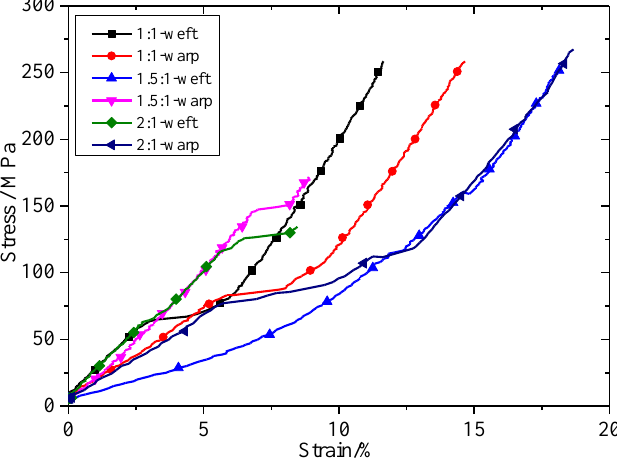
Figure 6. Stress–strain curves of the biaxial tensile tests under different loading ratios in warp and weft directions.